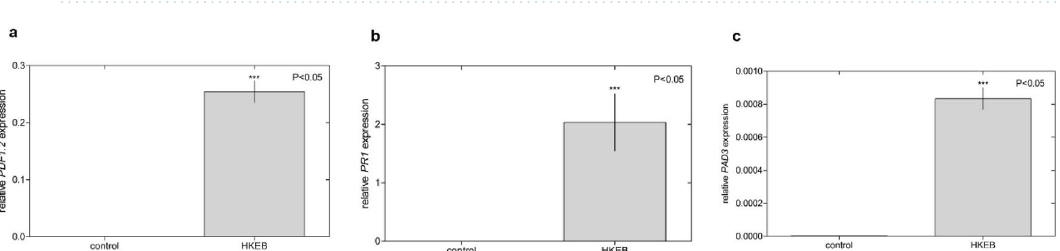
Figure 2. Relative level of expression of several genes associated with plant disease resistance in N. tabacum plants that were treated with HKEB ( a ), culture filtrate (CF) ( b ), and total protein (TP) ( c ) from B. aryabhattai . A molecular marker of the hypersensitive response (Hsr203J), PAL and β-1,3 glucanase were used in the analysis. The bars show the mean values with standard errors (n = 5).